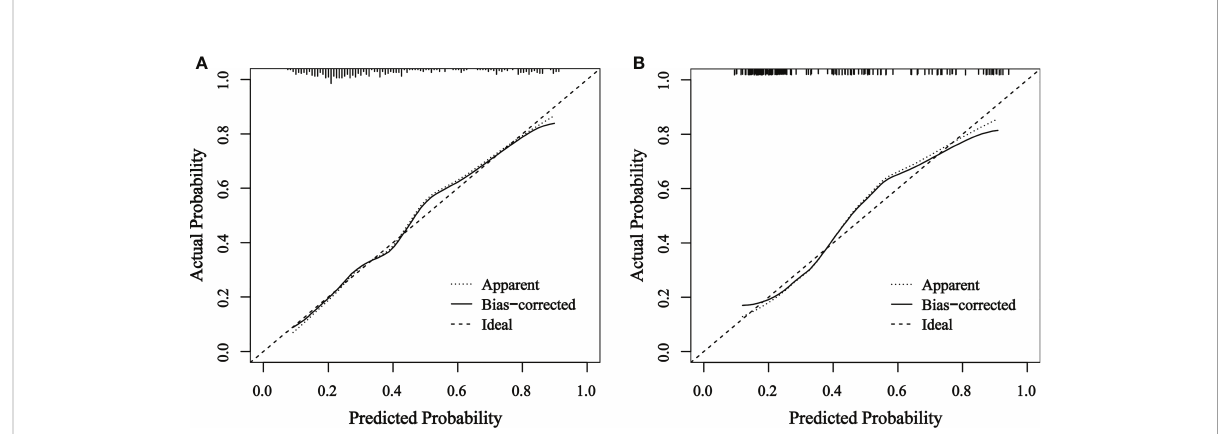
FIGURE 6 Calibration curve of actual and predicted probabilities of axillary pCR in (A) the training set and (B) the validation set The horizontal axis indicates the predicted probabilities measured by the nomogram and the vertical axis indicates the actual probabilities. pCR, pathologic complete